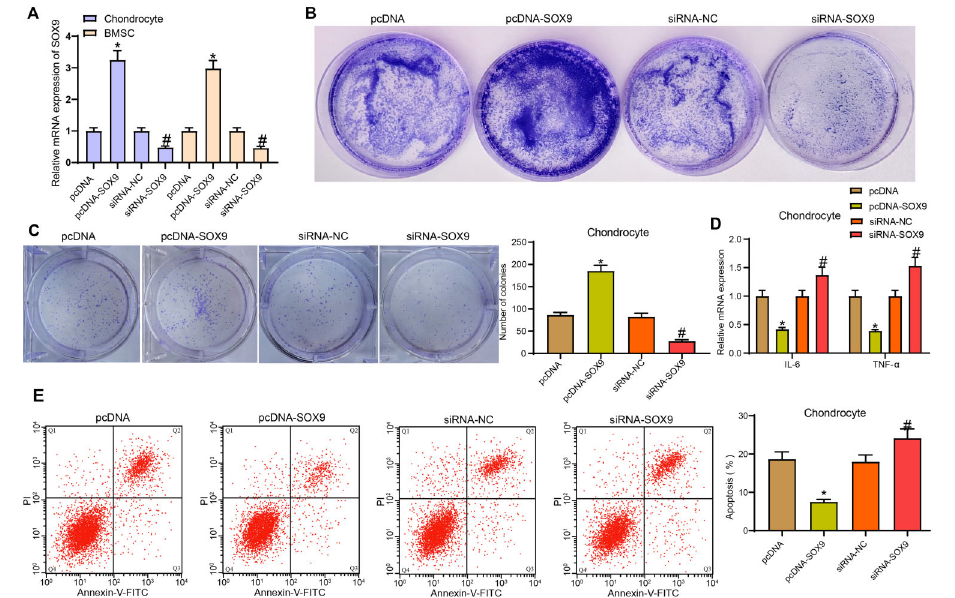
Figure 4. Overexpression of SOX9 promotes chondrogenic differentiation of bone marrow mesenchymal stem cells (BMSCs) and chondrocyte growth. A , Transfection ef fi ciency measured by RT-qPCR. B , Toluidine blue staining detected the effect of pcDNA-SOX9 and siRNA-SOX9 on the synthesis of extracellular matrix in the process of cartilage differentiation of BMSCs. C , Effect of pcDNA-SOX9 and siRNA-SOX9 on the proliferation of interleukin (IL)-1 b -treated chondrocytes measured by colony formation assay. D , RT-qPCR measured the effects of pcDNA-SOX9 and siRNA-SOX9 on the expression of IL-6 and TNF- a . E , Effect of pcDNA-SOX9 and siRNA- SOX9 on apoptosis of IL-1 b -treated chondrocytes measured by fl ow cytometry. The data in panels A, C, and E were processed using one-way ANOVA, and the data in panel D were analyzed using two-way ANOVA. *P o 0.05 compared to cells transfected with pcDNA; # P o 0.05 compared to cells transfected with siRNA-NC. Experiments were repeated 3 times